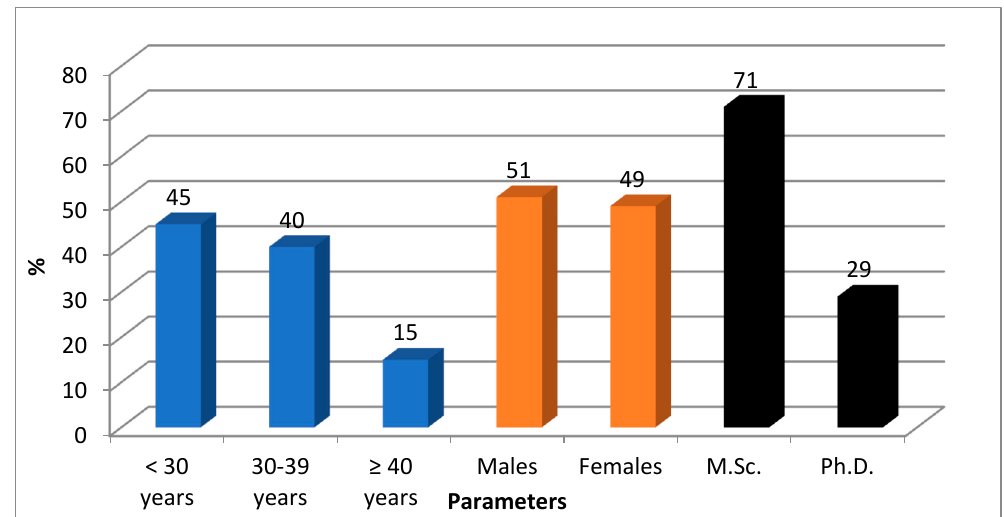
Figure 1. The demographical data of the participants. Table 1. Frequency distributions and percentages of the participant’s responses regarding the use and the type of social media.